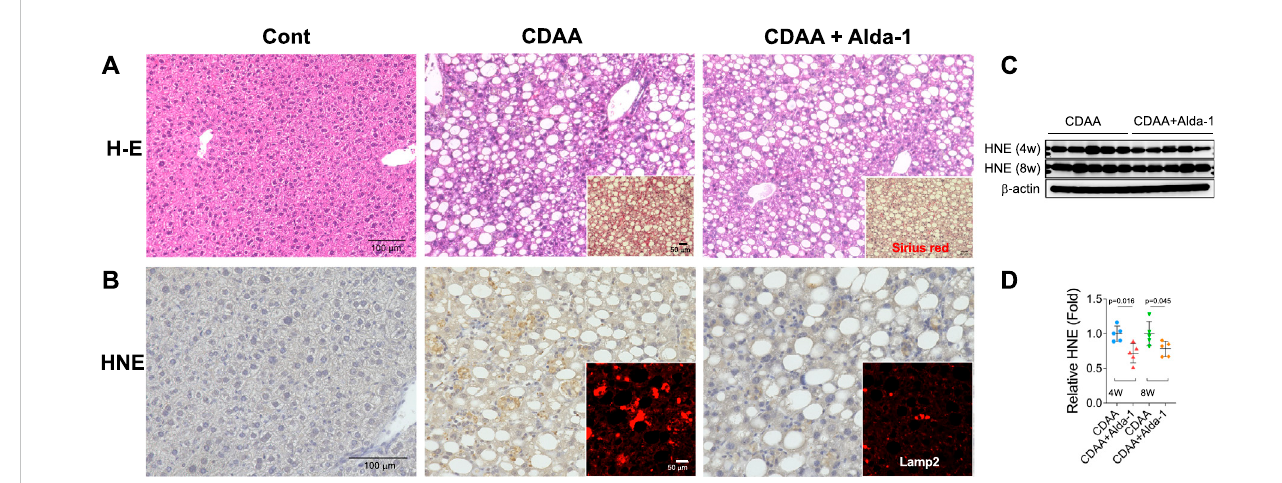
FIGURE 6 Alda-1inCDAAmicesuppressesliver fi brosis(PanelAandlysosomaldisintegrity(PanelB).Panels (A,B) rectangles:CDAAmiceshow fi brosisontheSirius red staining and lysosomal permeabilization on the Lamp-2 staining, while Alda-1 treatment (CDAA + Alda-1) disclosed decreased immunoreactivity of not only Sirius red and Lamp-2 but also HNE. Panel (C) Western blotting analyses of liver hydroxynonenal protein adducts in CDAA mice (CDAA) and CDAA mice with Alda-1 treatment (CDAA + Alda-1). Alda-1 treatment discloses decreased adducts. Panel (C) Each bands were quanti fi ed and shown as relative fold ratios. Adapted with permission from Seike et al.